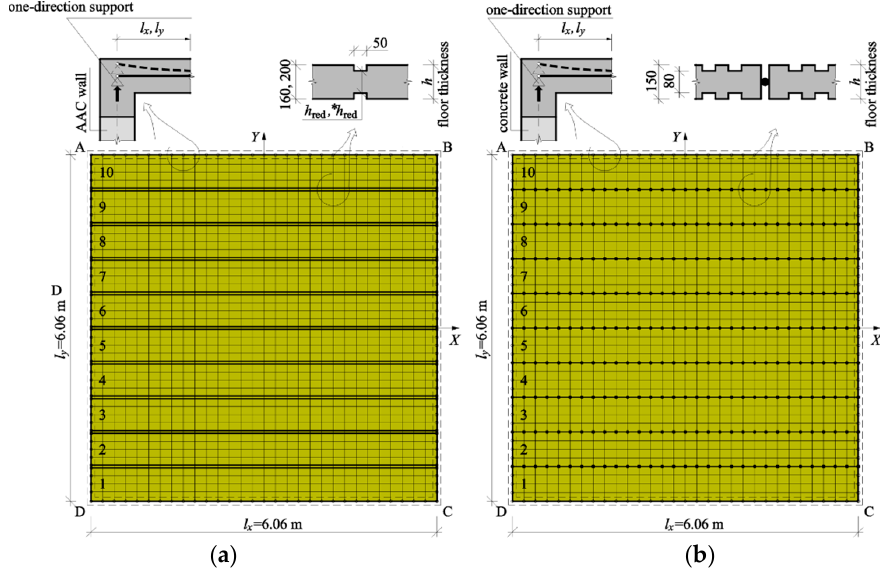
Figure 22. Numerical FEM models: ( a ) model LGR and RP; ( b ) model HC.